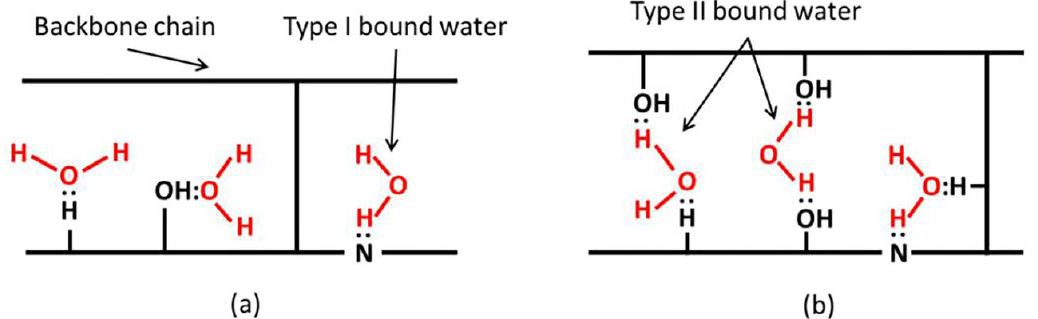
Figure 11. Two types between water molecules and polymeric chains, ( a ) Type I bound water forming one hydrogen bond, ( b ) Type II bound water forming two hydrogen bonds [42].